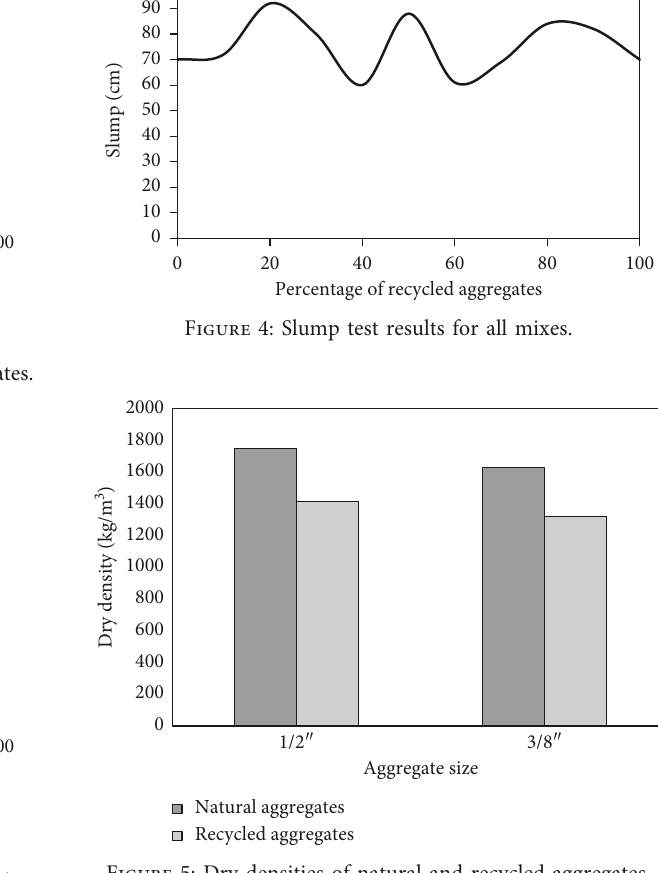
Figure 2: Grading of natural and recycled 3/8